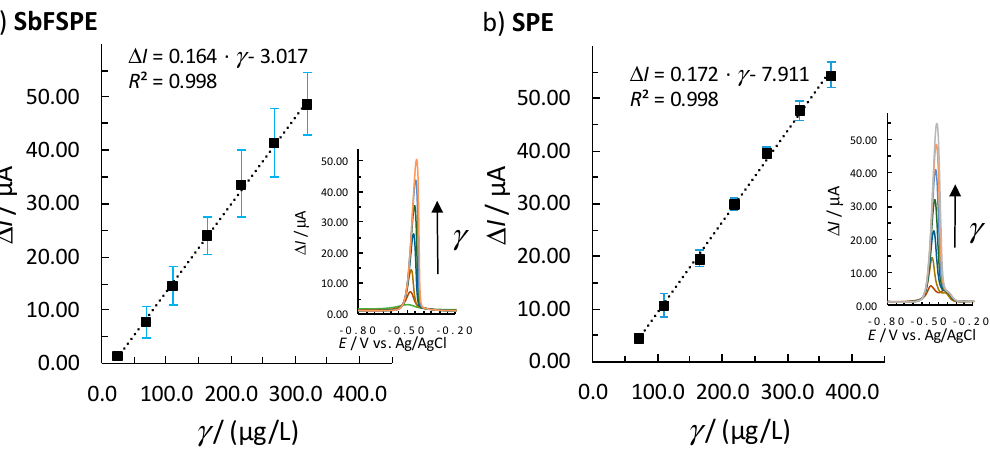
Figure 2. The linear Pb(II) concentration range measured in 0.01 M HCl for ( a ) SbFSPE (0.5 mg/L Sb(III)) and ( b ) bare SPE sensors; the error bars represent the standard deviation. Corresponding voltammograms with increasing Pb(II) concentrations (one out of three measurements) are shown in the insets. E acc of –1.1 V and t acc of 60 s were employed.